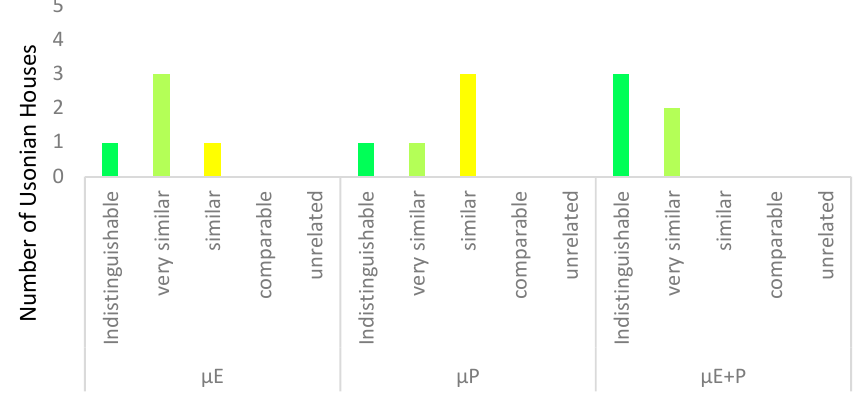
Figure 14. Qualitative comparison of Usonian houses and Fallingwater.